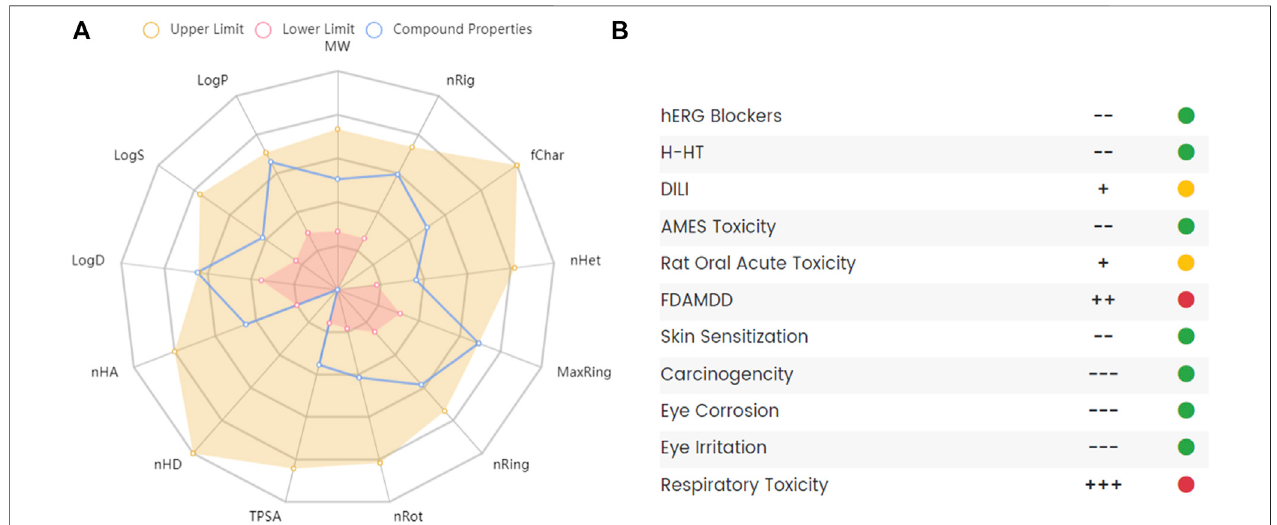
FIGURE8| Theabsorption,distribution,metabolism,excretionandtoxicity(ADMET)ofTHP. (A) RadarmapofTHPADMET. (B) ThepropertyanddecisionofTHP toxicity. The data obtained from the following websites: https://admetmesh.scbdd.com/.